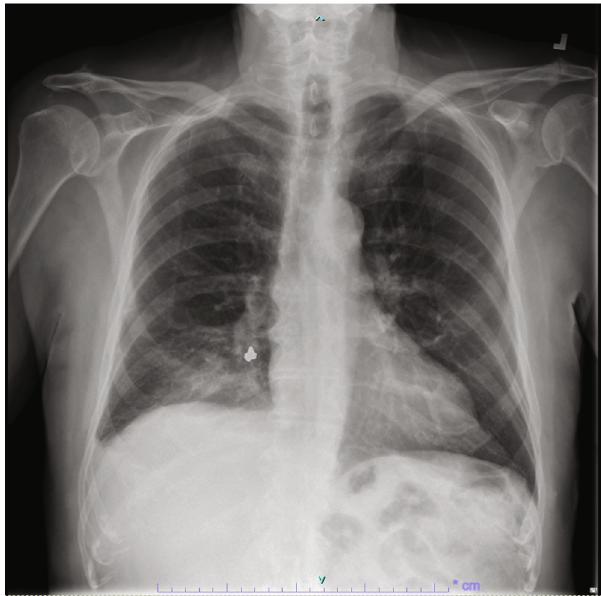
Figure 1: Anterior/posterior chest X-ray demonstrating radiopaque foreign body.